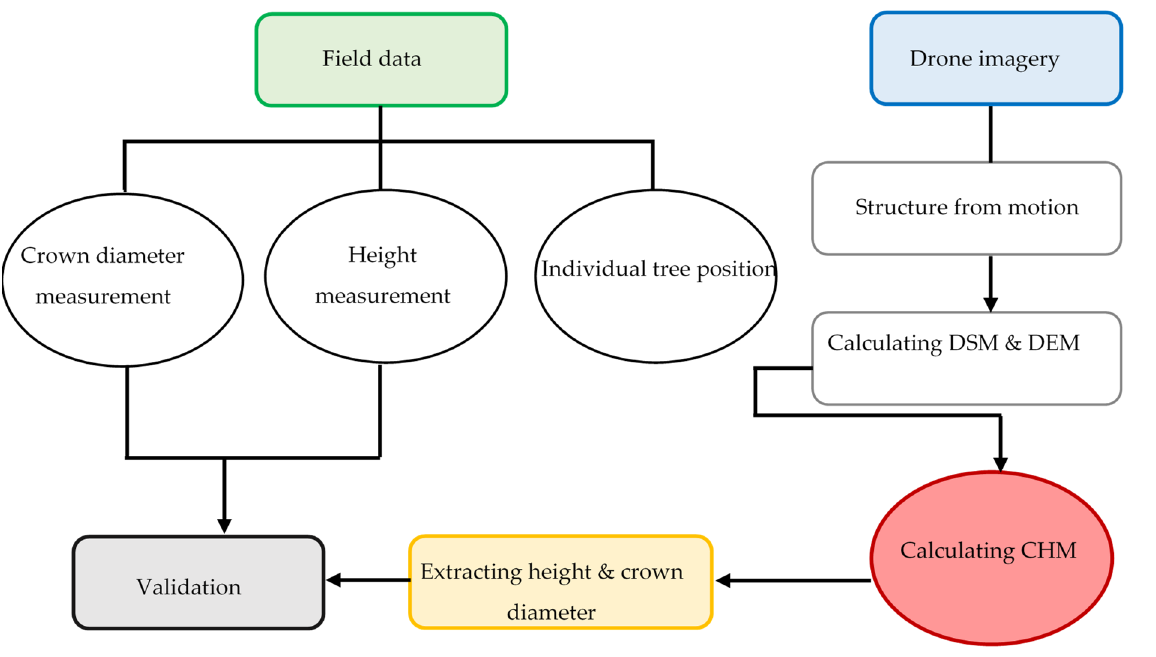
Figure 2. A flow chart to illustrate the analysis and outputs.